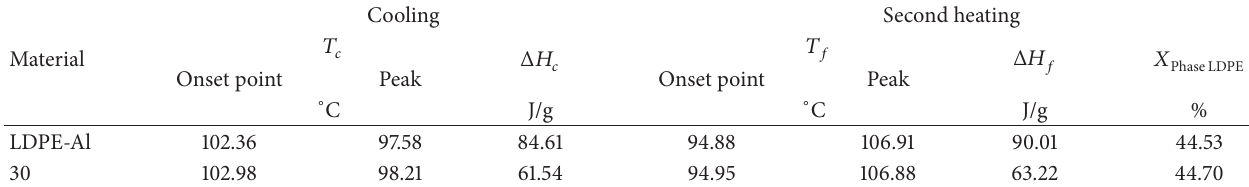
Table 1: Degree of crystallinity ( 𝑋 ) estimated for the polyethylene phase for each of the materials